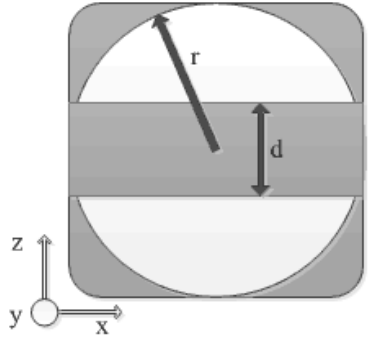
Fig. 1. The D-aperture for the generation of multiple light sheets. The spatial ¯lter is placed at the pupil plane of illumi- nation lens for generation of multiple spots